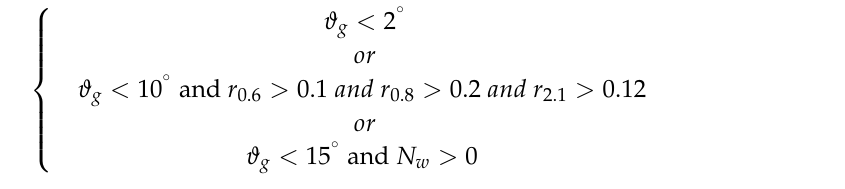
e δ ∆ T ) in n × n b 3.9